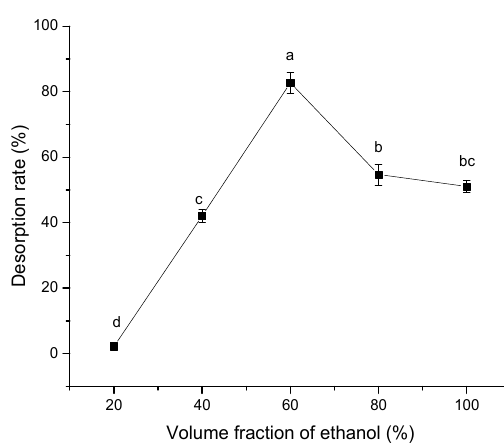
Figure 8. Desorption rate of D101 resin (3 g) adsorbing polyphenols from distiller’s grains with eluent of 20%, 40%, 60%, 80% and 100% ethanol under the condition of 30 °C at 120 rpm for 24 h. Values with the same letter of a differ insignificantly ( P < 0.05) per Duncan’s multiple range test. Vertical bars represent the standard deviation of each value.